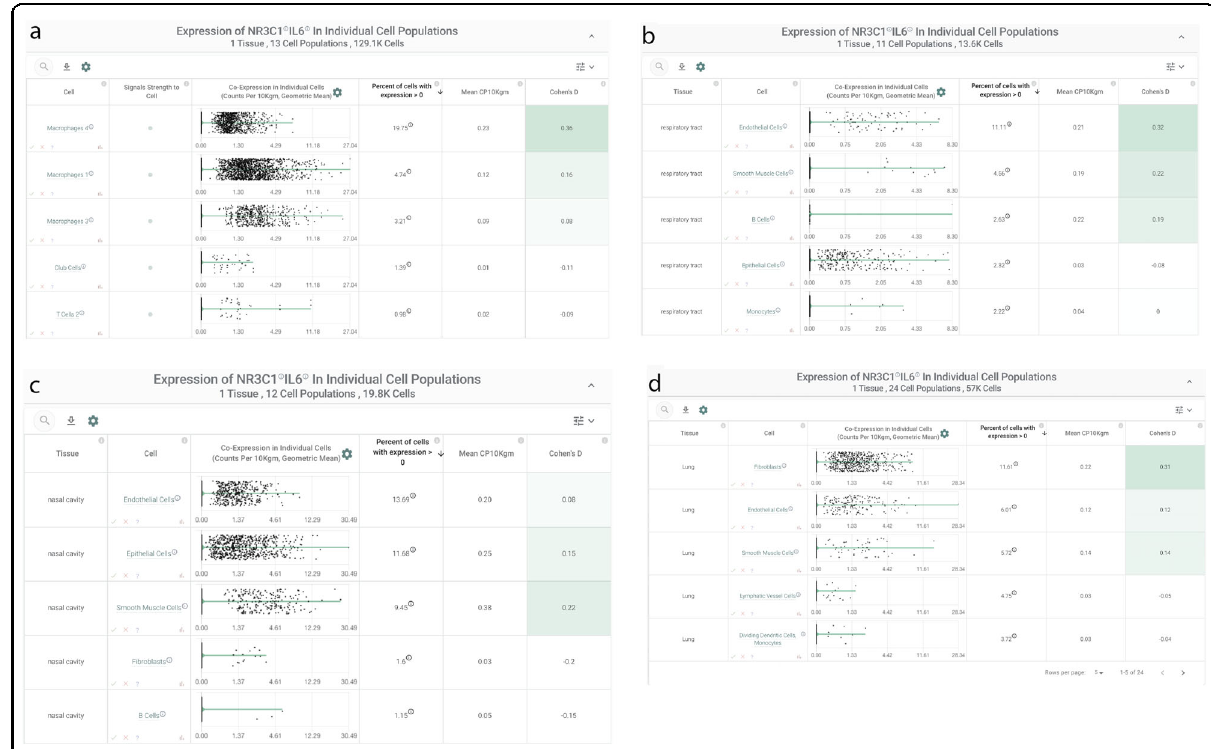
Fig. 6 IL-6/NR3C1 co-expression by single-cell RNA-sequencing. A Bronchoalveolar lavage fl uid of COVID-19 patients; and ( B ) – ( D ) nasal cavity, respiratory tract,